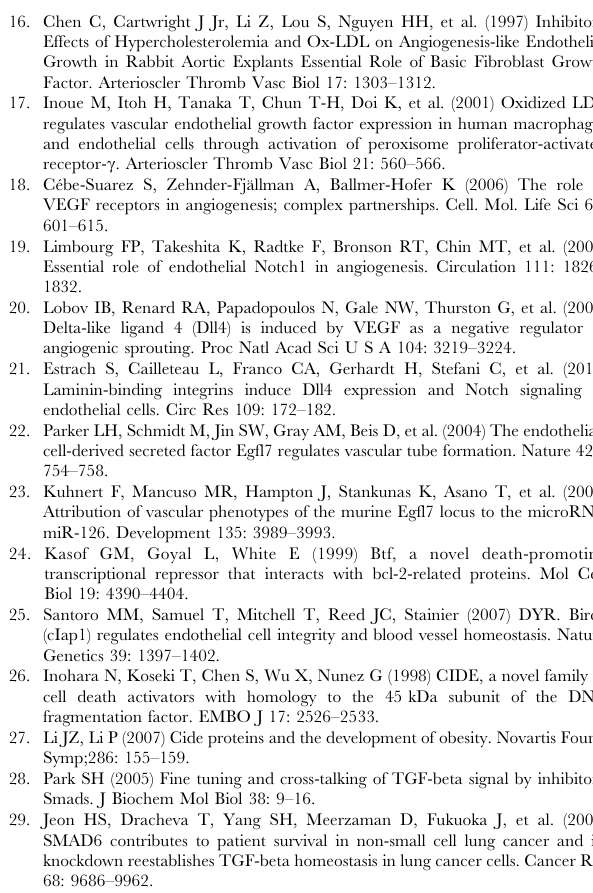
Figure S1 Pathway analysis for LOX-1 antibody sensi- tive upregulated and downregulated genes ( $ 1.5-fold difference, p , 0.05) that were defined as those that reversed to control values by more than $ 30%. (TIF) Table S1 List of differentially expressed genes ( $ 2-fold difference, p , 0.01). Table S2 List of differentially expressed genes ( $ 1.5- fold difference, p , 0.05). Table S3 List of LOX-1 antibody sensitive upregulated and downregulated genes ( $ 1.5-fold difference, p , 0.05) that were defined as those that reversed to control values by more than $